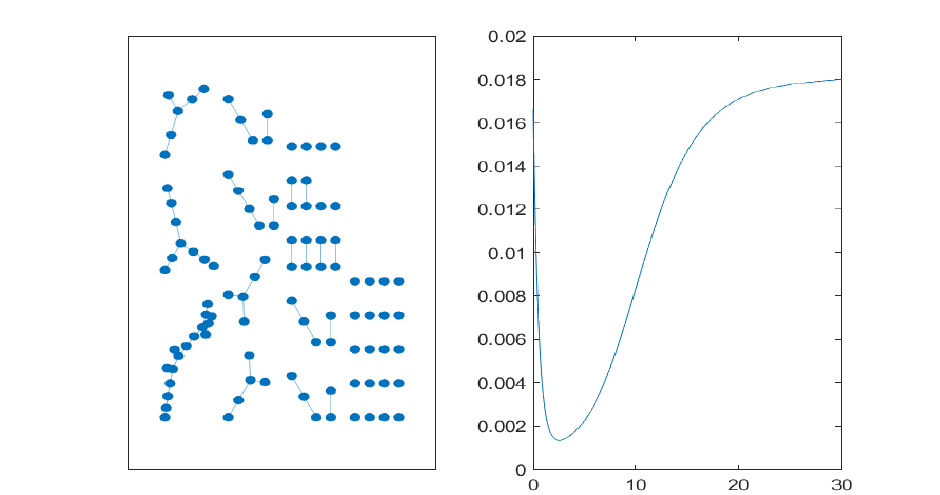
Figure 4. Low level of connectivity:Erdös–Rényi graph with 100 nodes and a connection probability of p = 0.01 ( left ). Time evolution of the mean value of non-performing loans on the graph ( right